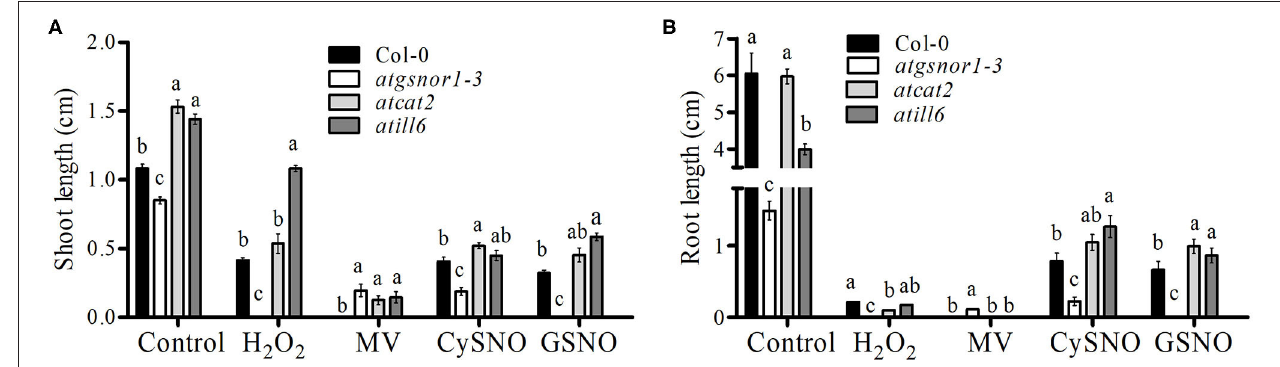
FIGURE 1 | The response of atill6 and relevant control plants after exposure to oxidative (H2O2 and MV), and nitrosative (CySNO and GSNO) stress conditions. (A) Shoot and (B) Root lengths. All data points show the mean of at least three replicates, and the experiment was repeated twice with similar results. The significant difference between the treatments is represented by (a, b, c) one-way ANOVA analysis of varience, followed by Duncan’s multiple range test using statistical analysis system (SAS